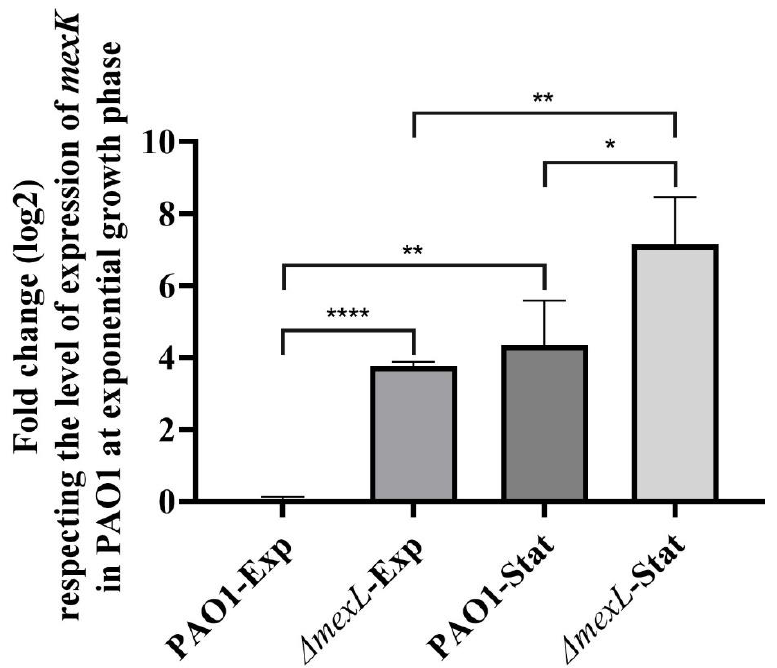
Figure 2. Effect of MexL and growth phase on mexJK expression. The expression of mexK was determined by RT-qPCR in both PAO1 and ∆ mexL strains at stationary and exponential phases of growth. Fold change regarding the level of expression of mexK in PAO1 at exponential growth phase is presented. As shown, lack of MexL highly increased mexK expression, indicating that, in agreement with previous reports [59,60], MexL is a negative regulator of mexJK . In addition, expression was higher at stationary growth phase in both strains, indicating that growth-phase regulation of mexK expression is independent of MexL. Values that are significantly different by an unpaired two-tail t -test are indicated by asterisks as follows: * p < 0.05; ** p < 0.01; **** p < 0.0001.